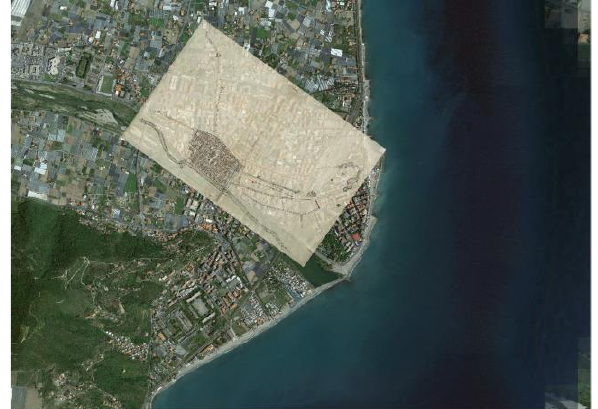
Figure 10. Georeferenced historic map in